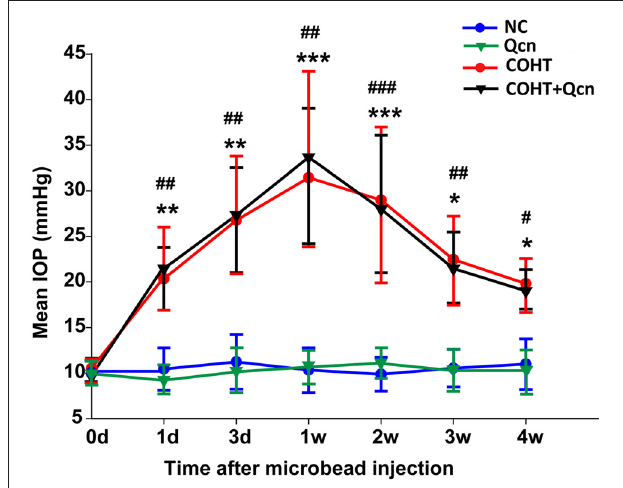
FIGURE 1 | Mean intraocular pressure (IOP) of rats in the NC, quercetin (Qcn), chronic ocular hypertension (COHT) and COHT+Qcn groups. IOP was observed from 0 weeks to 4 weeks after microbead injection. The data are given as the mean ± standard deviation (SD); # p < 0.05, ## p < 0.01 and ### p < 0.001 for the COHT group compared with the NC group. ∗ p < 0.05, ∗∗ p < 0.01 and ∗∗∗ p < 0.001 for the COHT+Qcn group compared with the Qcn and NC